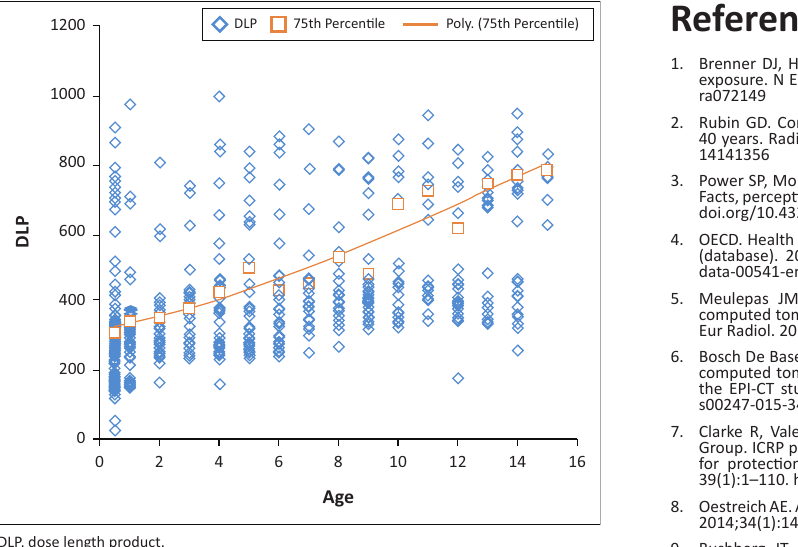
FIGURE 3: Polynomial exponential curve for the purpose of presenting diagnostic reference levels for computed tomography brain for specific ages. The data set used in this graph was the dose length product for computed tomography brain examinations, corrected for each year in age ( n =